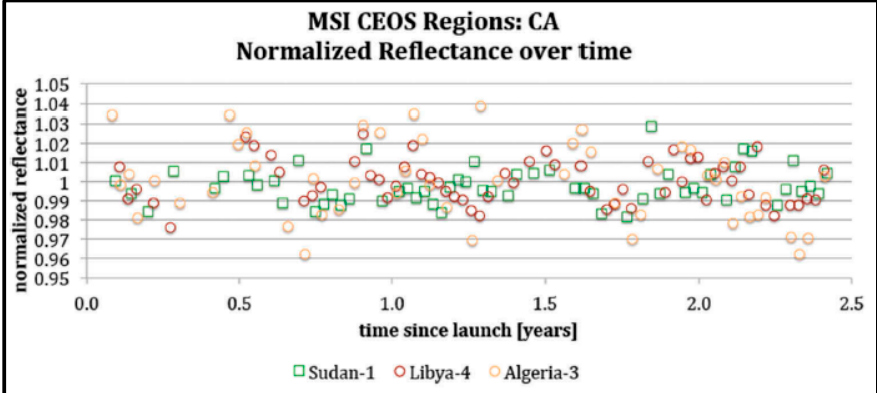
Figure 6. The lifetime trend of Sentinel-2A MSI at three PICS [54]. Remote Sens. 2020 , 11 , x FOR PEER REVIEW